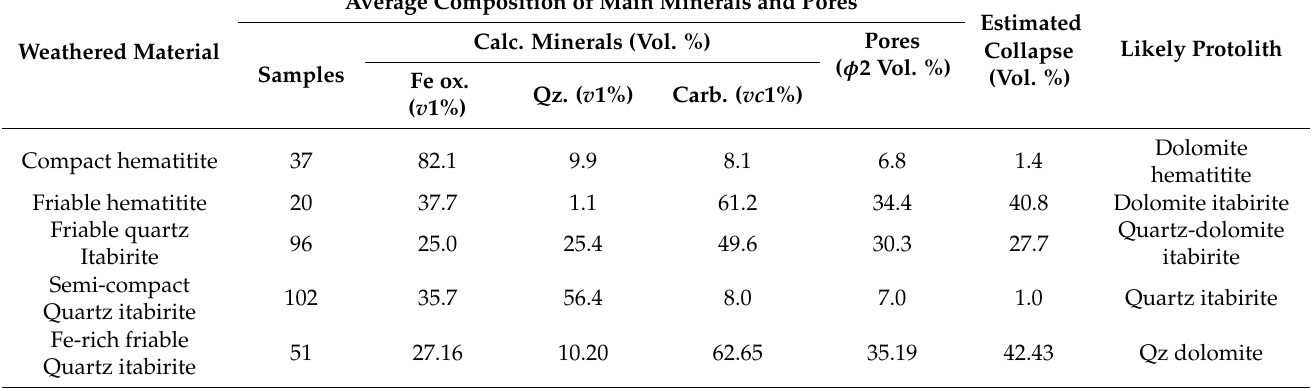
Figure 12. Original mineralogy and porosity in a volume of dolomite (DO), leaching volume, and final result friable quartz itabirite (IF) with 36% of porosity and 65% of original volume collapsed. Table 5. Average calculated mineralogical composition (only main components) and porosity of the studied materials, estimated collapse, and their likely protolith with null porosity ( ϕ 1 = 0).